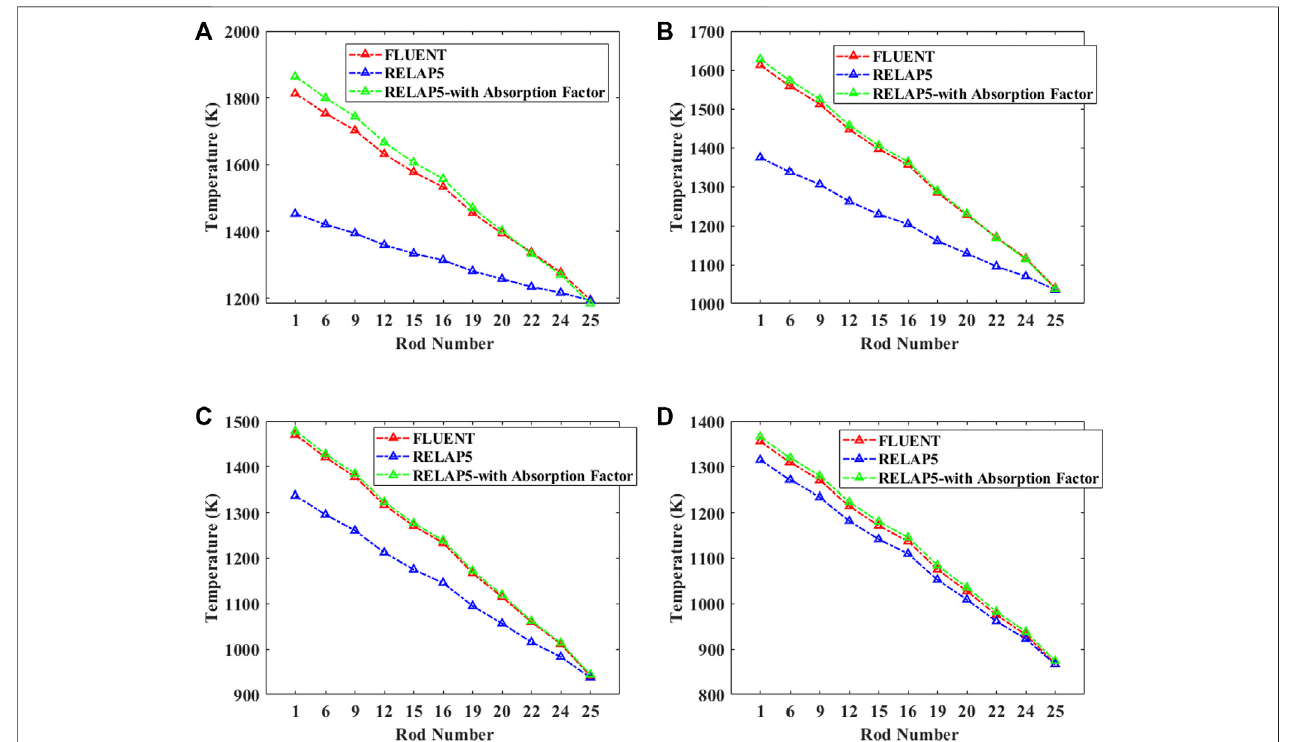
FIGURE 10 | Temperature results for p/d = 1.2: (A) emissivity = 0.3, (B) emissivity = 0.5, (C) emissivity = 0.7, and (D) emissivity = 0.9.